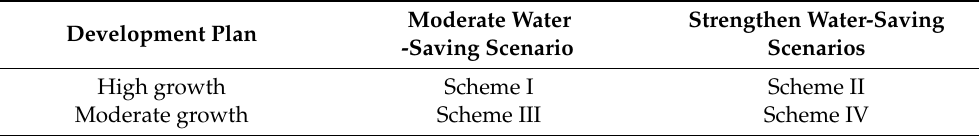
Table 4. Setting of water demand forecasting